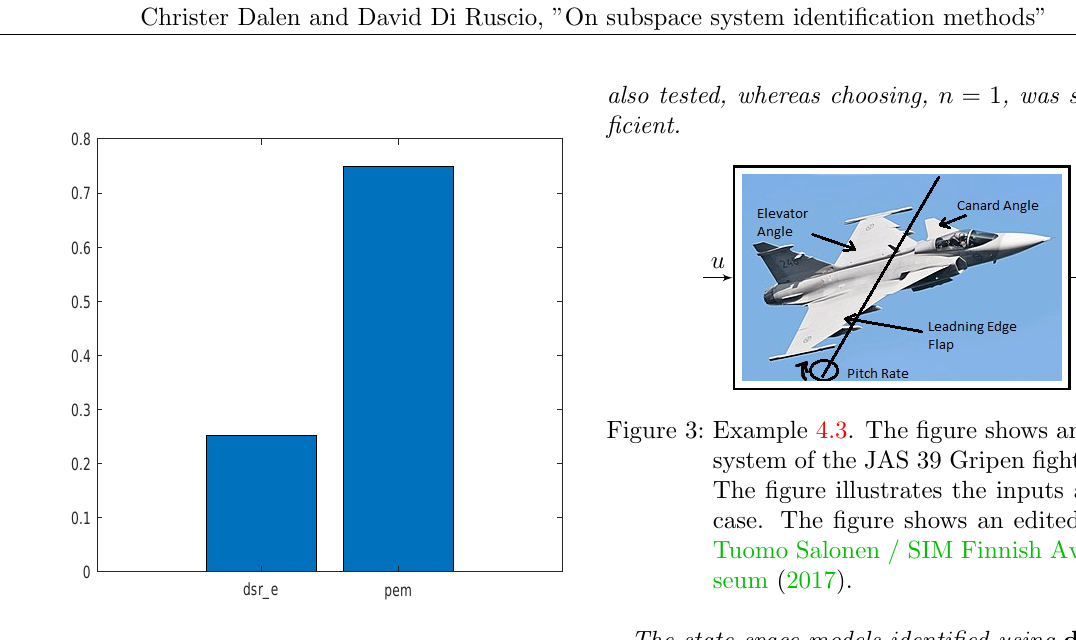
Figure 2: Example 4.2. dsr e and pem based on random discrete space model Monte Carlo simulations. dsr e